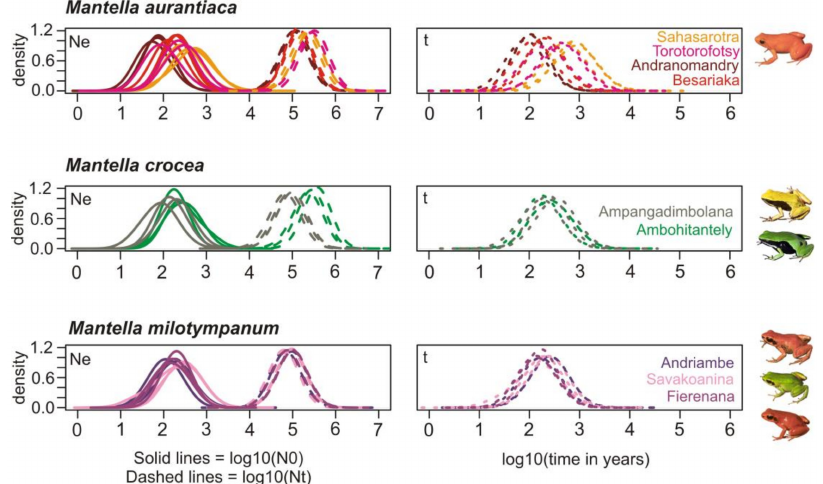
Figure 8. Demographic history of the analyzed Mantella spp. populations. For each sampling locality the estimated current e ff ective population size (solid lines; Ne graph), the ancestral e ff ective population size (dashed lines; Ne graph) and the time of the bottleneck (dashed lines; t graph) are shown. Each population presents three curves corresponding to the posterior distribution using three di ff erent priors reflecting a bottleneck, expansion and stable demographic scenarios. Each sampling locality is represented with a di ff erent color (name color key is shown in the t graphs). Ne, e ff ective population size; t, time in